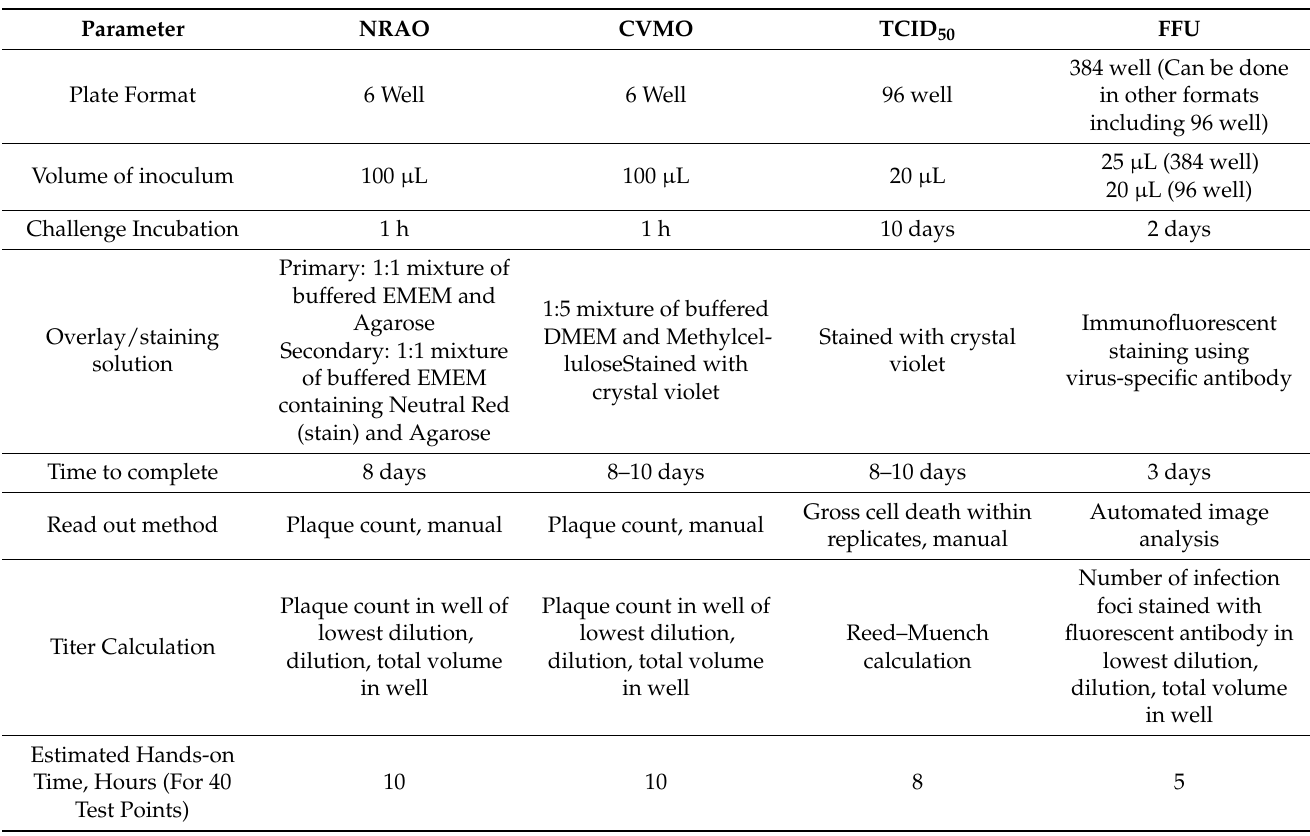
Table 1. Assay Overview Comparison. Comparison between each viral titering method. Each assay type presents a fundamentally different method of determining viral titer, and requires differences in time and sample volume. Plate formats may vary. For the purposes of this paper, the FFU assay was done in a 384 well format. Methods for use in a 96 well format have been included in this